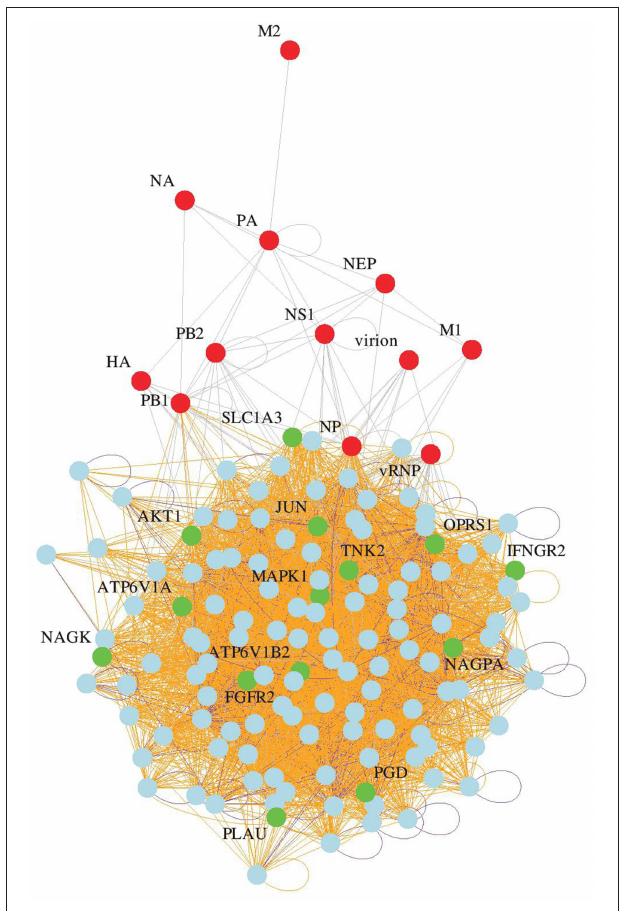
FIGURE 1 | Identification of candidate drugs. Network of influenza host factors with drug targets highlighted. From the network of 128 consensus human host genes (22), 319 virus and gene/protein interactions were retained. Among the 128 nodes, 14 gene targets of FDA-approved drugs were identified by a custom Perl script that identifies direct as well as alternative gene name matches in the DrugBank flat file version 3.0